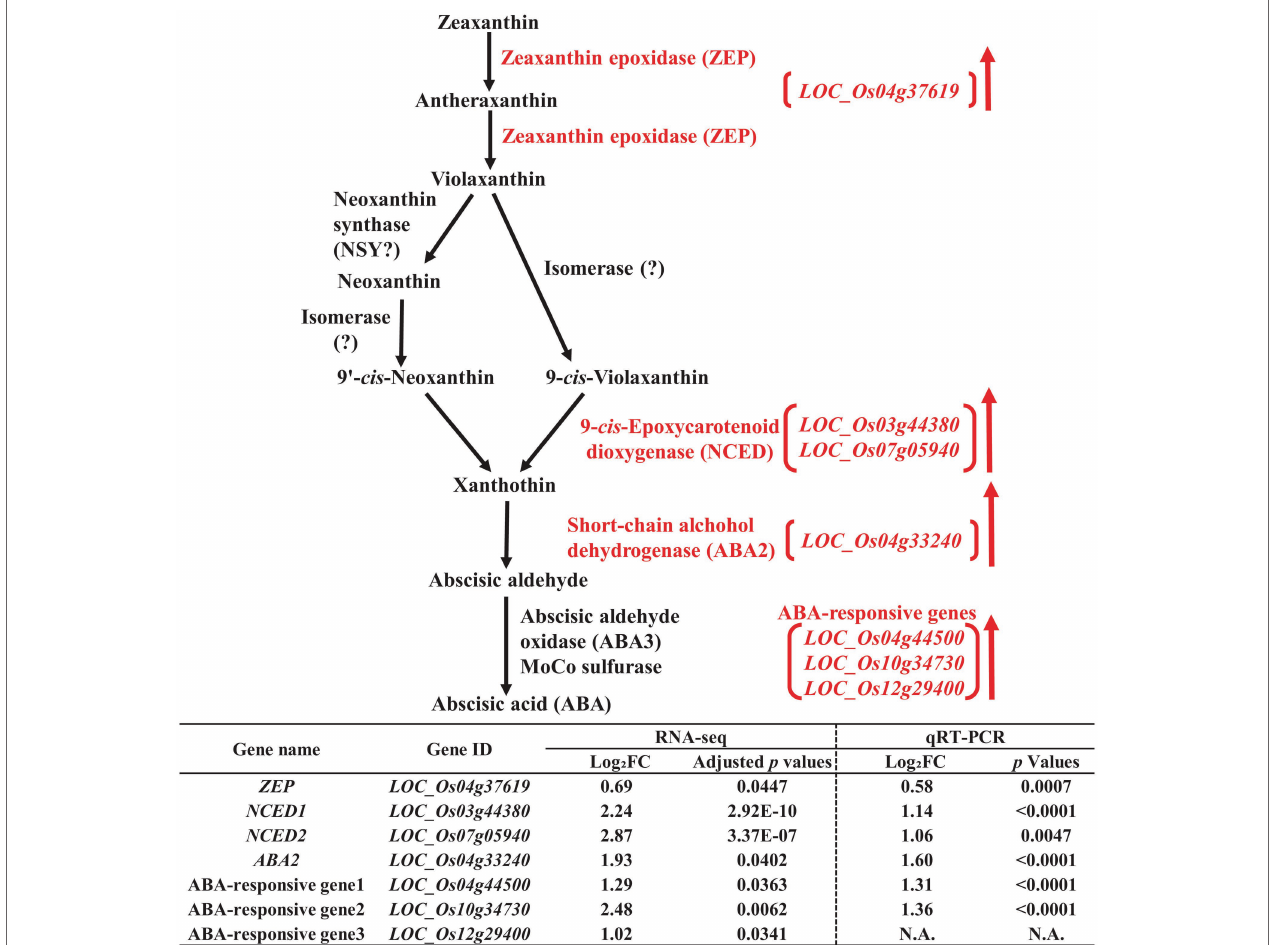
FIGURE 3 | Biosynthetic pathway of abscisic acid (ABA) in the developing seeds of Samgwang grown on reclaimed land (RL) and verification of upregulated genes through qRT-PCR. ↑ indicates upregulation. The Log 2 FC (FC, fold change) expresses the Log 2 value of a ratio of expression value of RL to that of normal land (NL; RL/NL), which was generated by RNA-seq and qRT-PCR, respectively, from the developing seeds of Samgwang. The significant difference for each dataset was determined by t